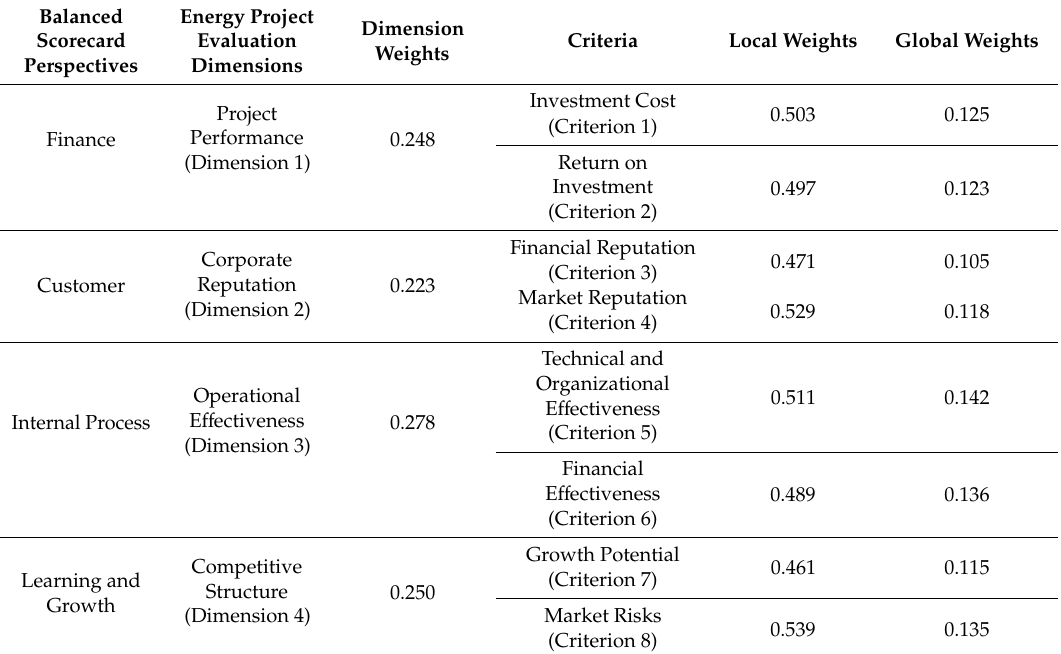
Table 6. Weights of Criteria and Dimensions.